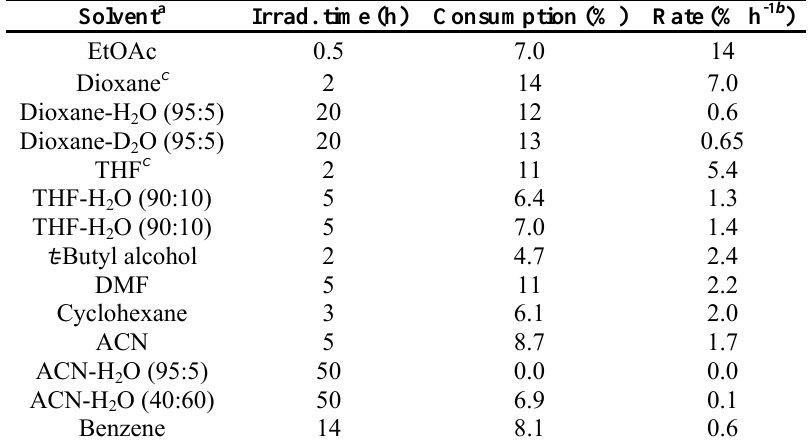
Table 11. Solvent effects on the consumption rate of 2'-hydroxychalcone 88a